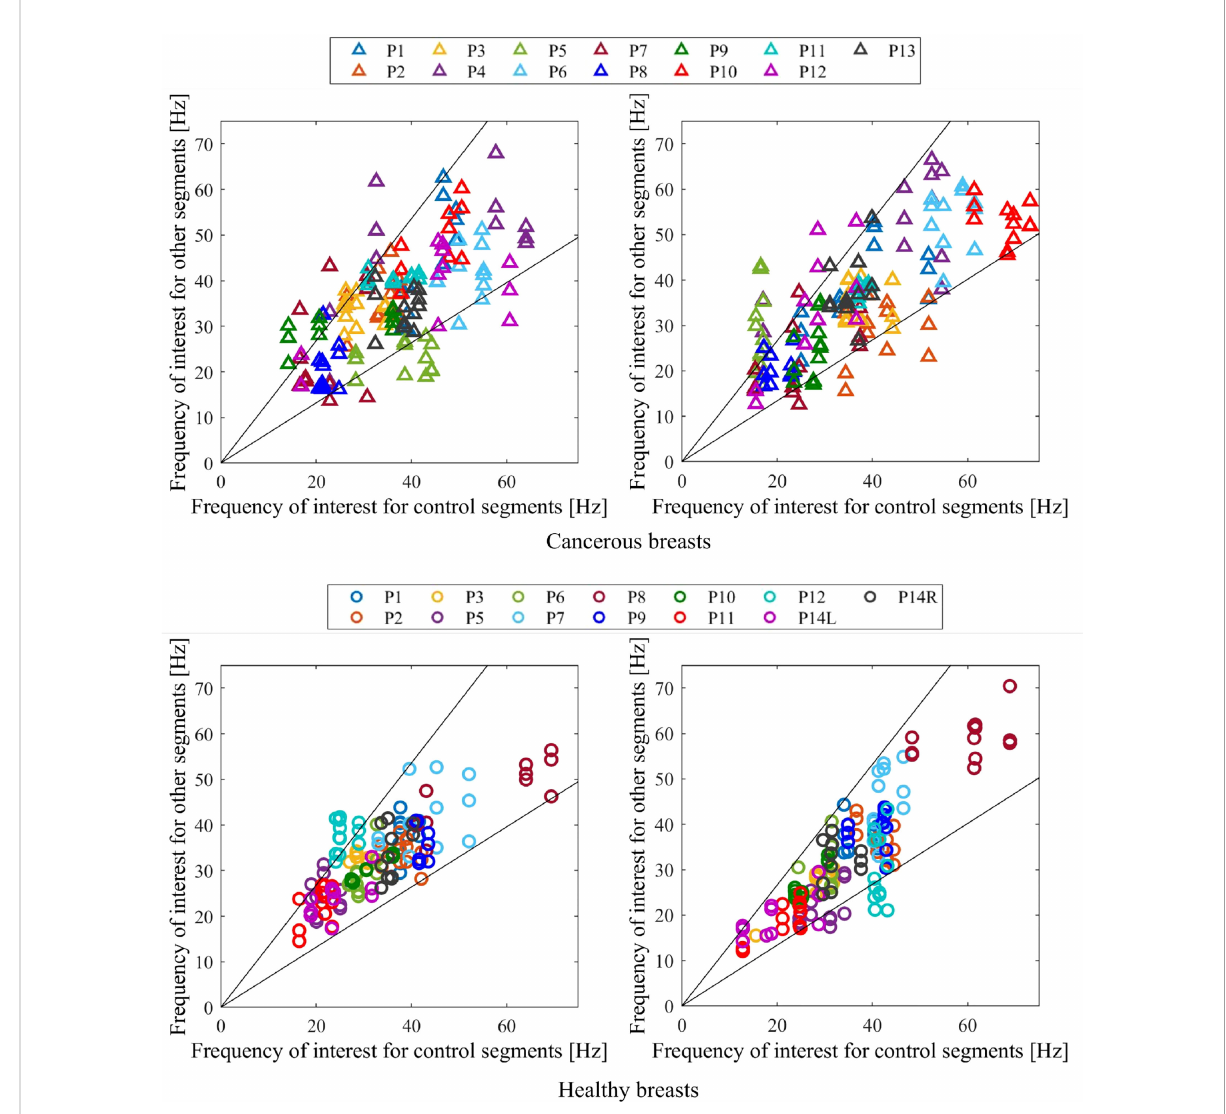
FIGURE 6 Diagnostic criteria for cancerous (top) and healthy (bottom) breasts for con fi guration 6 with 34% tolerance applied (left) and con fi guration 1 with 33% tolerance applied (right). Any one point lying outside the percentage tolerance shown results in a cancerous